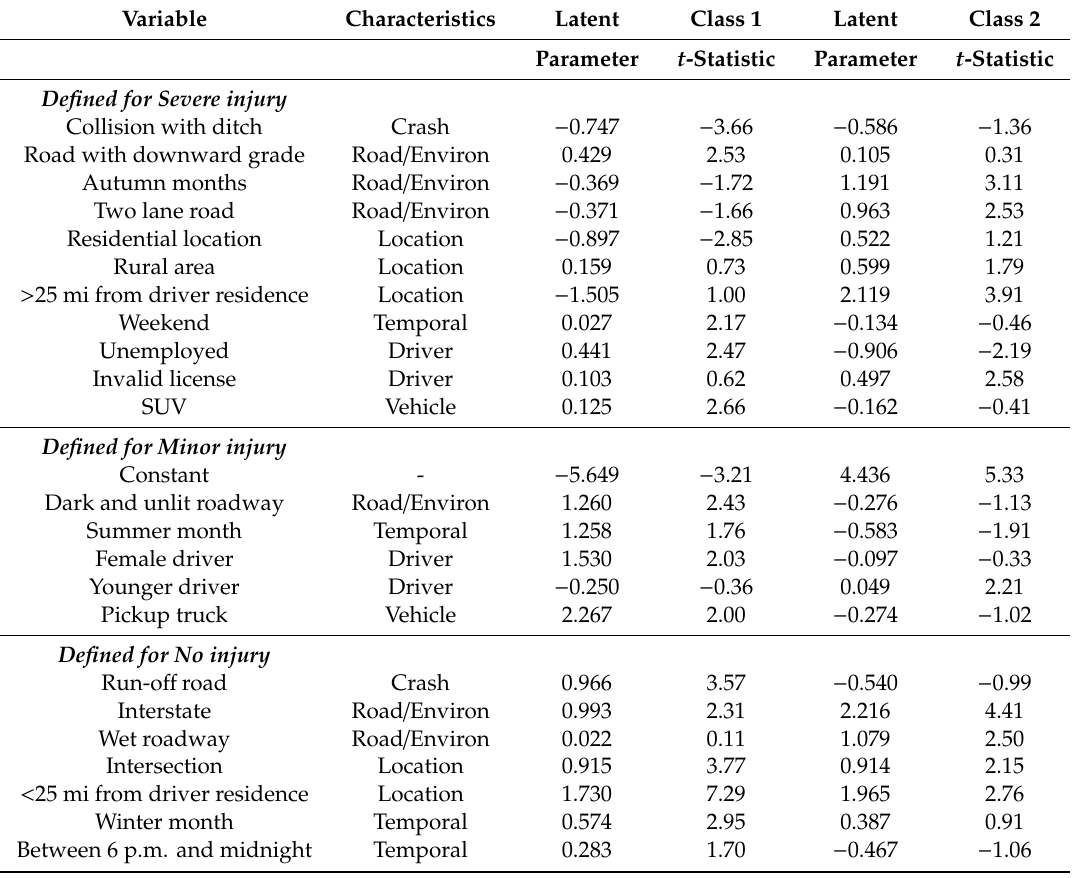
Table 2. Latent class logit model estimation results for single-occupant driving under the influence (DUI)